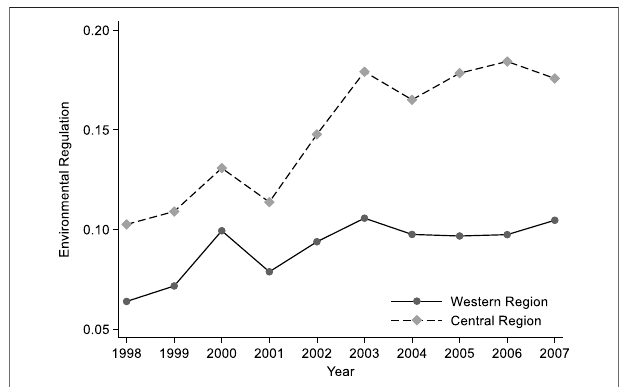
FIGURE 1 | Differences in environmental regulation on both sides of the boundary between central and western China. Note : The SO 2 removal rate was used to measure the degree of environmental